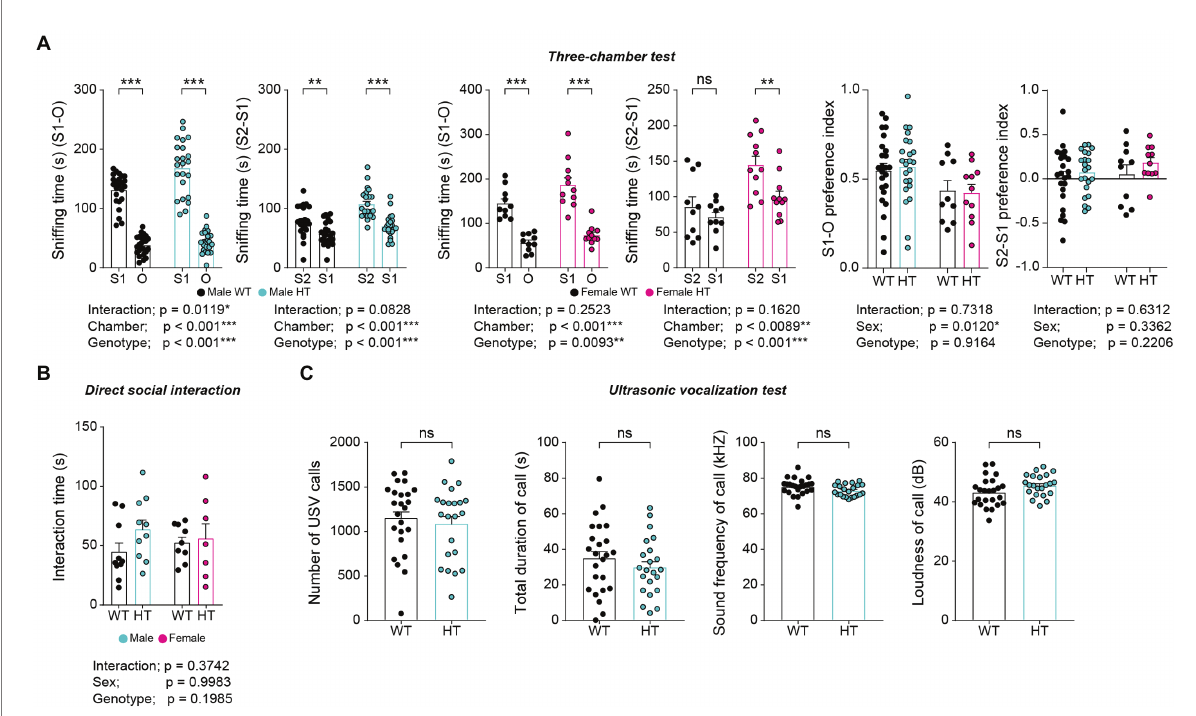
FIGURE 4 Normal social behaviors in adult male and female Chd8 +/S62X mice. (A) Male and female Chd8 +/S62X mice (3 months) show normal levels of social approach and social novelty recognition in the three-chamber test compared with WT mice, as shown by time spent sniffing a social stranger (S1) versus object (O), or a novel stranger (S2) versus a familiar stranger (S1), and the preference index (difference in time spent sniffing different targets over total time spent sniffing). ( n = 24 mice [male-WT], 23 [male-HT/heterozygote], 10 [female-WT], and 11 [female-HT], * p < 0.05, ** p < 0.01, *** p < 0.001, ns, not significant, two-way ANOVA with Holm-Sidak test [separate ANOVA for males or females], * p < 0.05, two-way ANOVA [preference index]). (B) Male and female Chd8 +/S62X mice (3 months) show normal levels of direct social interaction in the dyadic social-interaction test compared with WT mice, as shown by total interaction time (nose-to-nose, nose-to-tail, following, mounting, and allo-grooming). ( n = 10 mouse pairs [male-WT], 10 [male-HT], 9 [female-WT], and 7 [female-HT], two-way ANOVA). (C) Male Chd8 +/S62X mice (3–4 months) show normal levels of USVs upon encountering a female stranger compared with WT mice, as shown by the number of calls, duration of each call, call sound frequency, and call loudness. ( n = 24 mice [WT], 22 [HT], ns, not significant, Student’s t